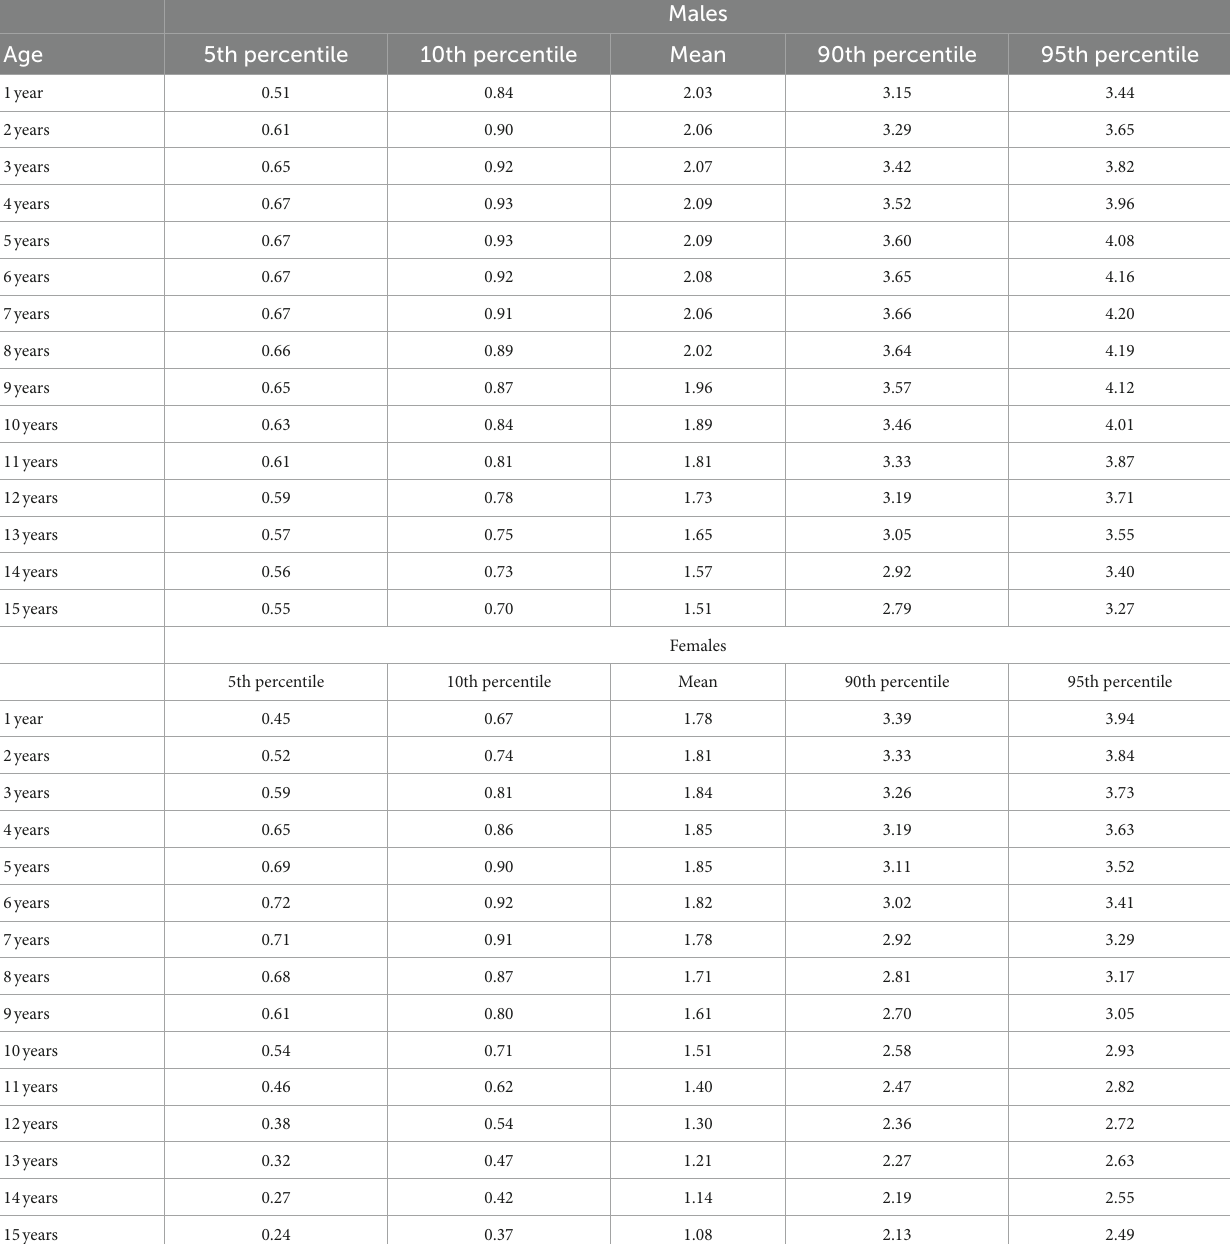
TABLE 4 Normative values for bone conduction (BC) c-VEMP amplitude-ratio as modeled for age-specific reference intervals using the Royston and Wright method (26).